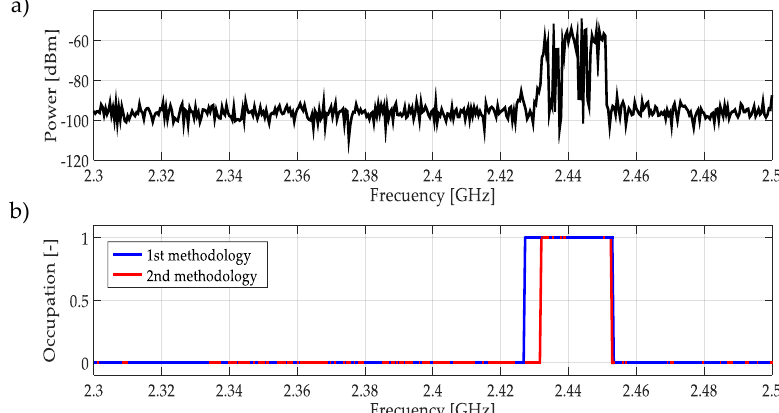
Figure 24. ( a ) A real signal obtained from the frequency band [1.7–2] GHz. ( b ) The result of applying both methodologies to the real signal in terms of spectrum occupancy. In this case, the second methodology gives a better frequency edge detection.